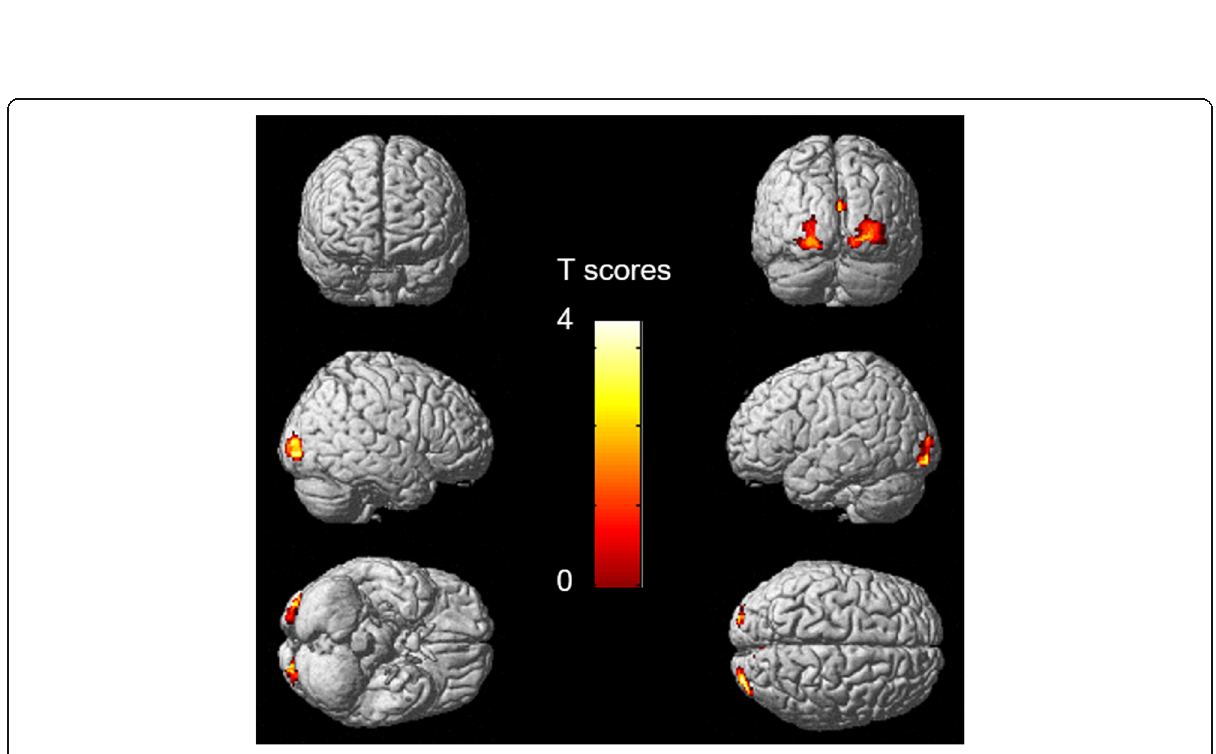
Fig. 4 Anatomical localization of areas of increased left precentral gyrus connectivity in patients with acrophobia after VRET ( p < 0.005, k > 84) projected onto 3D volume rendering. After the VRET, patients showed increased connectivity between the left precentral gyrus and bilateral occipital areas (BA17-18-19). L : left, R :